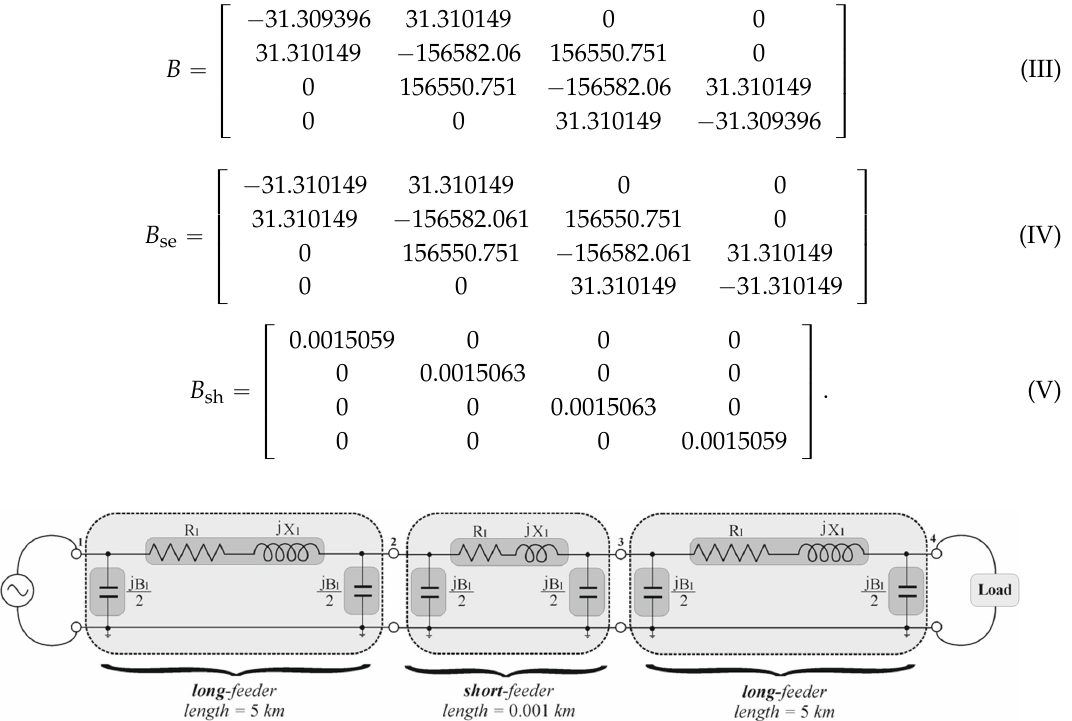
Figure A1. A single phase equivalent ‐π circuit [2] of a 4 ‐ bus illustative network. Here, series and shunt parts of reactive power loss are considered. Table A1. Data of the ilustrative 4 ‐ bus network shown in Figure 5.